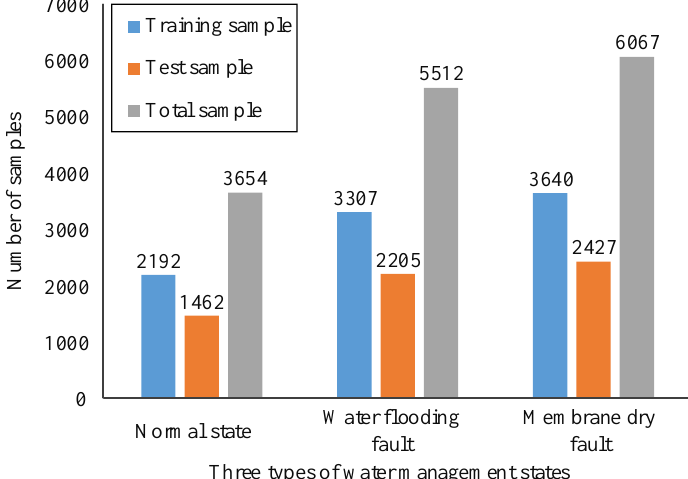
Figure 5. Partition graph of training set and test set.